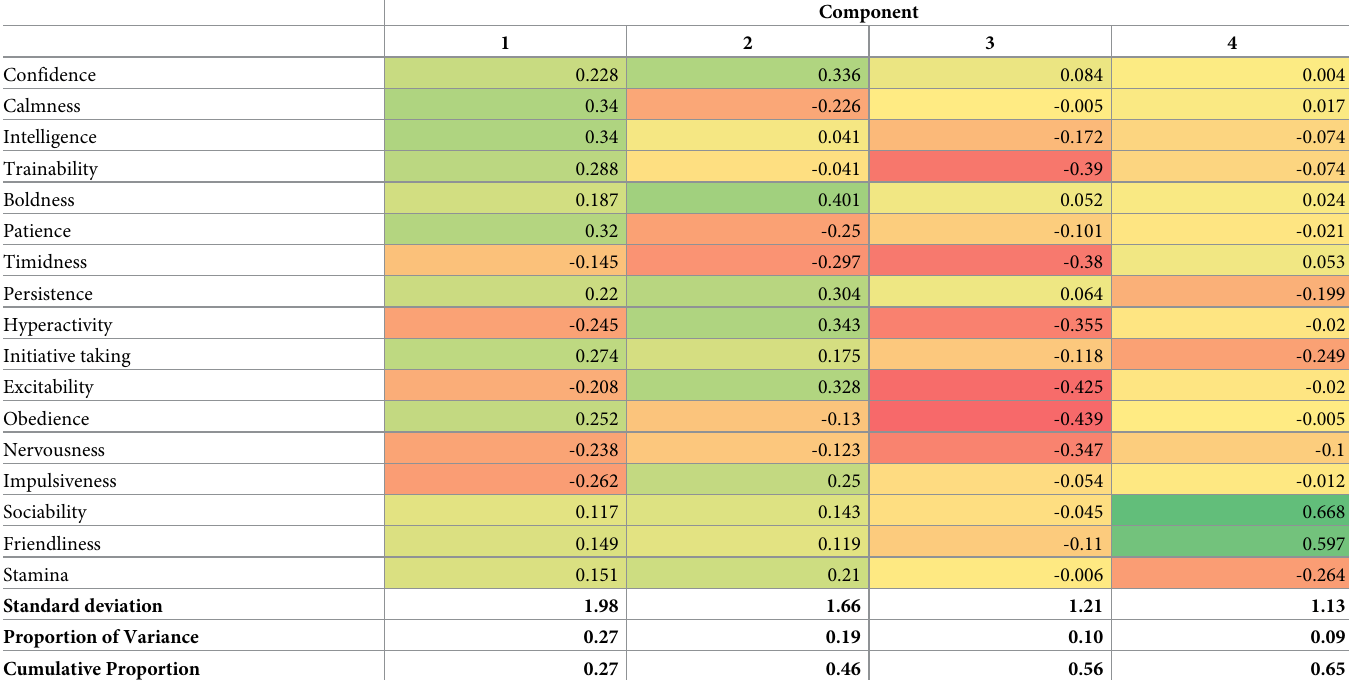
Table 4. Summary of the results of principal component analyses of owner ratings of 210 working Kelpies on 17 personality terms. Red and orange shading has been used for negative loadings and green and yellow shading for positive loadings with the darker shading indicative of a loading of higher magnitude ( > 0.2) than the lighter shading.